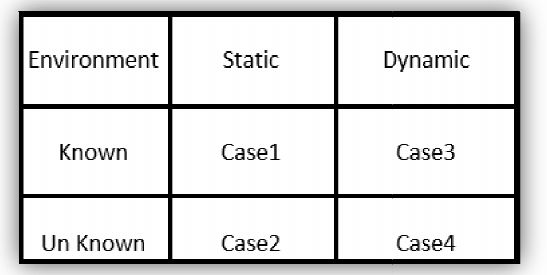
Fig. 1. Classification of Path planning based on